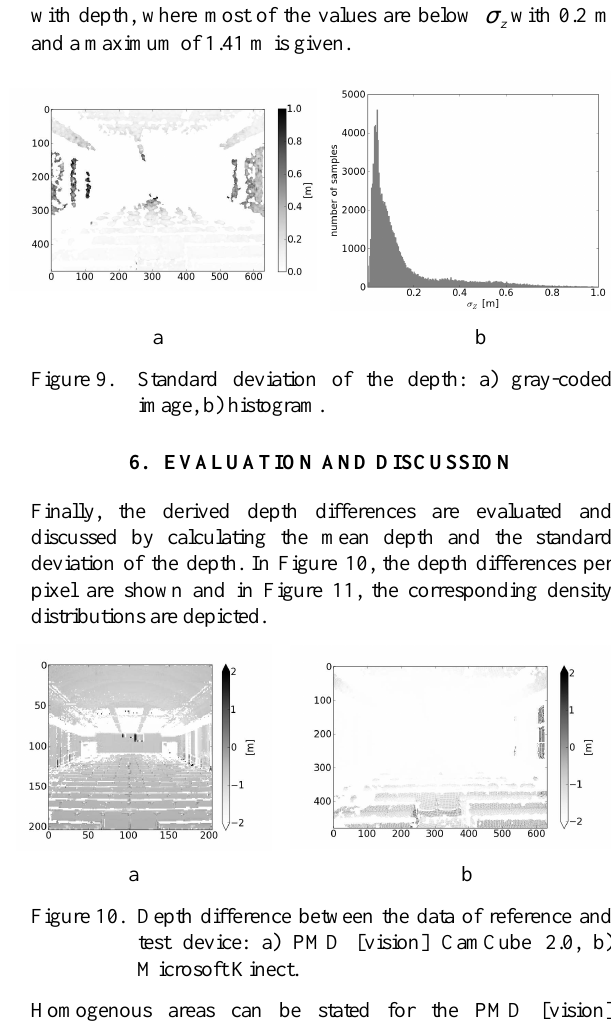
Figure 12. Density distribution (blue dotted) and mean (red solid) of depth z versus standard deviation of the depth difference s z : a) PMD [vision] CamCube 2.0, b) Microsoft